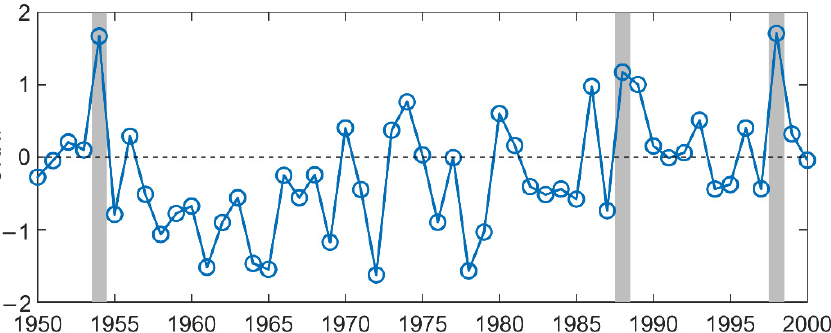
Figure 6. Okhotsk high index (OKHI) in summertime from 1950 to 2000, based on the geopotential height data in NCEP/NCAR reanalysis dataset [27], the shadow indicates years that OKHI ≥ 1.0.